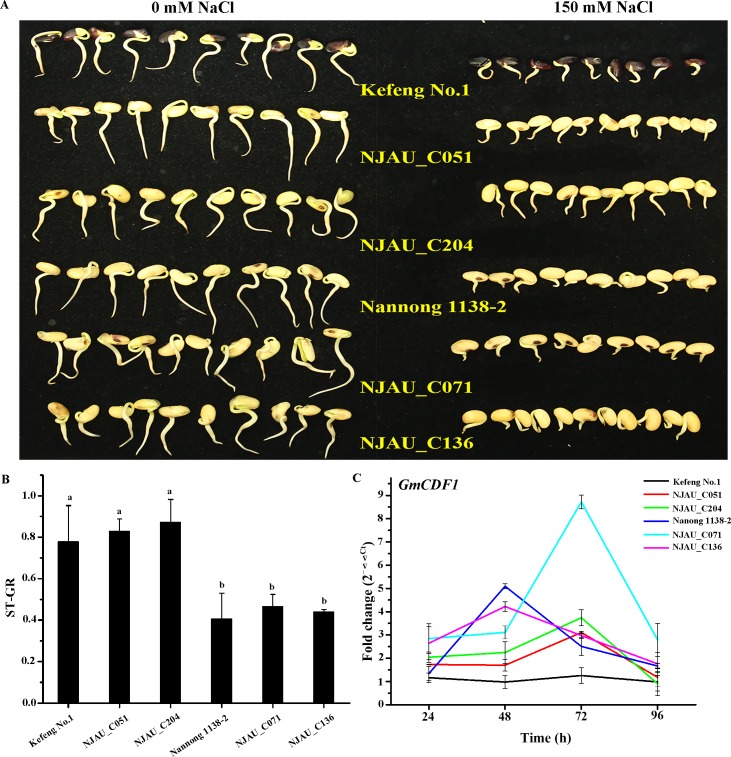
Germination of six soybean cultivars and expression of GmCDF1 under normal or salt stress conditions.(A) The salt-tolerant soybean cultivars (Kefeng No.1, NJAU_C051 and NJAU_C204) performed better than the salt-sensitive cultivars (Nannong 1138–2, NJAU_C071 and NJAU_C136) under salt stress. (B) The ST-GR values of the salt-sensitive soybean cultivars (Nannong 1138–2, NJAU_C071 and NJAU_C136) were lower than those of the salt-tolerant cultivars (Kefeng No.1, NJAU_C051 and NJAU_C204). Different letters at the top of each column indicate significant differences, as determined by ANOVA (p < 0.05). The data are presented as the means±SEs. (C) Expression analysis of GmCDF1 in soybean cultivars (Kefeng No. 1, NJAU_C051, NJAU_C204, Nannong 1138–2, NJAU_C071 and NJAU_C136) after treatment with 150 mM NaCl for 24 h, 48 h, 72 h and 96 h at the germination stage. The data are presented as the means±SEs.